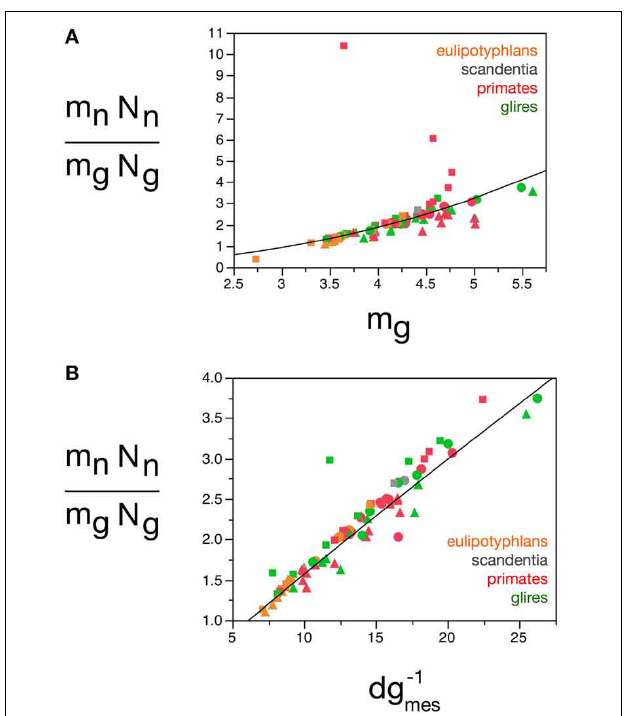
FIGURE 13 | Neuron/glia mass ratio varies with average glial cell mass across brain structures and species. Graphs show the neuron/glia mass ratio ( m n N n / m g N g ) as (A) a function of estimated glial cell mass ( m g ) and (B) a function of the inverse of measured glial cell density ( d − 1 gmes ) in each brain structure in each species. Average glial cell mass in picograms; d − 1 gmes in picograms/neuron. Functions plotted are (A) m n .N n / m g .N g = 0.064 m g 2 . 433 ± 0 . 260 ( r 2 = 0 . 528, p < 0 . 0001) and (B) m n .N n / m g .N g = 0.132 d − 1 gmes 1 . 072 ± 0 . 034 ( r 2 = 0 . 926, p < 0 . 0001). Cerebral cortex plotted as circles, cerebellum as squares, and rest of brain as triangles; eulipotyphlans shown in orange, primates in red, and rodents in green. Data from Herculano-Houzel et al. (2006, 2007, 2011), Azevedo et al. (2009), Sarko et al. (2009), and Gabi et al. (2010).